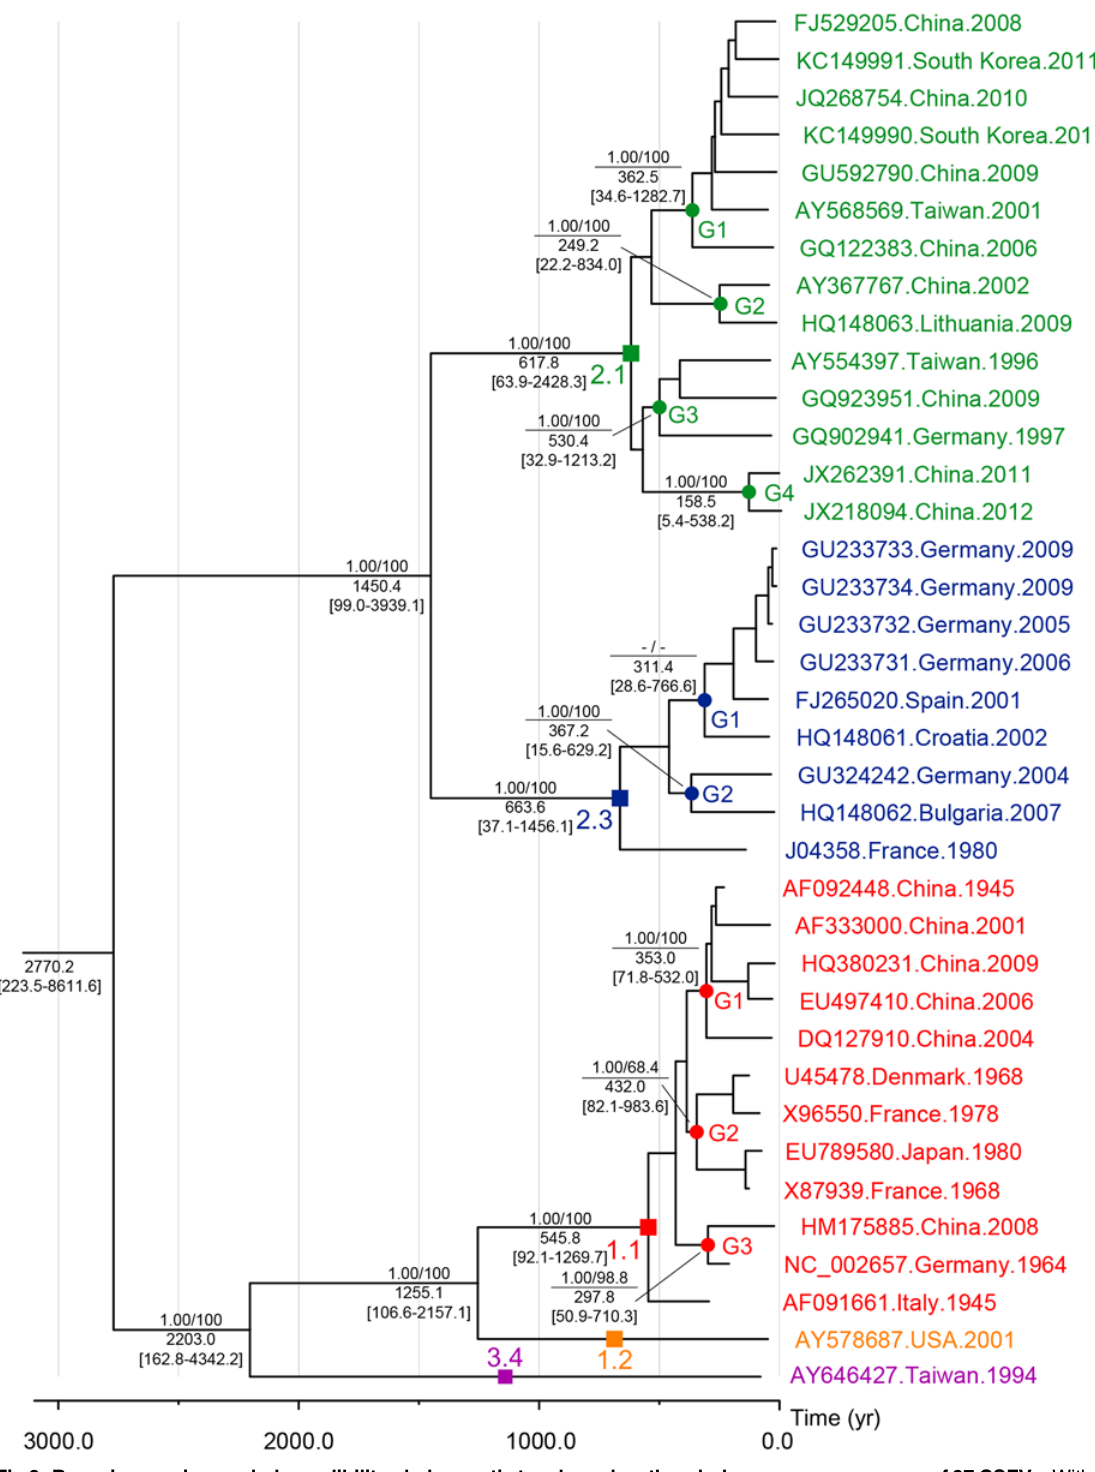
Fig 3. Bayesian maximum clade credibility phylogenetic tree based on the whole genome sequences of 37 CSFVs. With the BI and ML methods, identical topology was produced. Divergence times (in years) are positioned below the nodes; the 95% HPD intervals are indicated in brackets. The confidence of the phylogenetic analysis is presented above the nodes: left numbers represent Bayesian posterior probabilities ( (cid:1) 0.80) and right ones represent ML bootstrap values ( (cid:1) 60%). Subgenotypes and groups are indicated above the corresponding nodes using squares and circles.